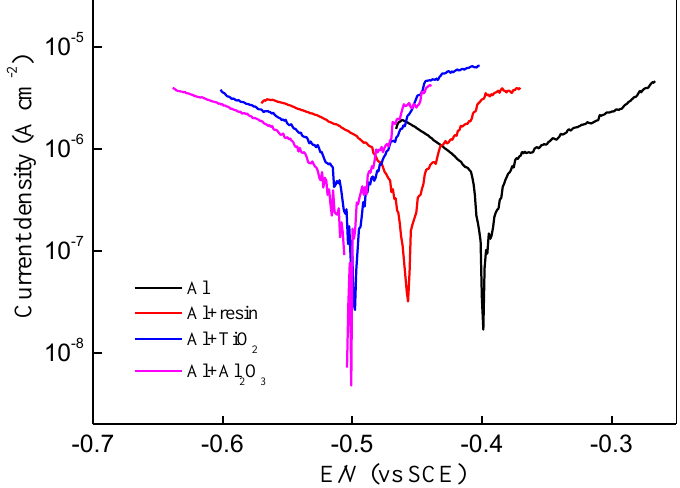
Figure 1. Polarization curves of the studied samples. Table 1. Corrosion properties of the studied samples obtained from polarization curves. Samples